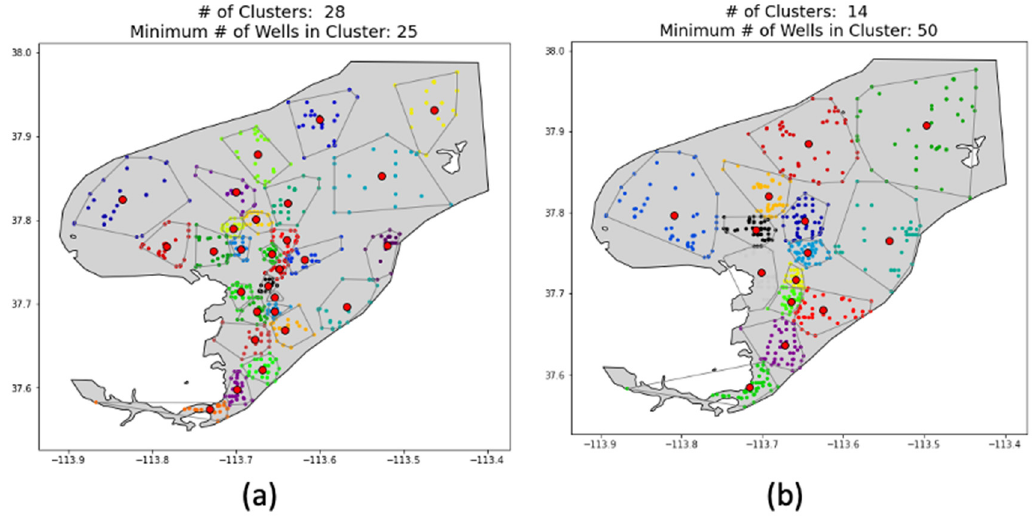
Figure 7. Well clusters and pseudo-wells for the k-means-constrained method with ( a ) 25 wells and ( b ) 50 wells.